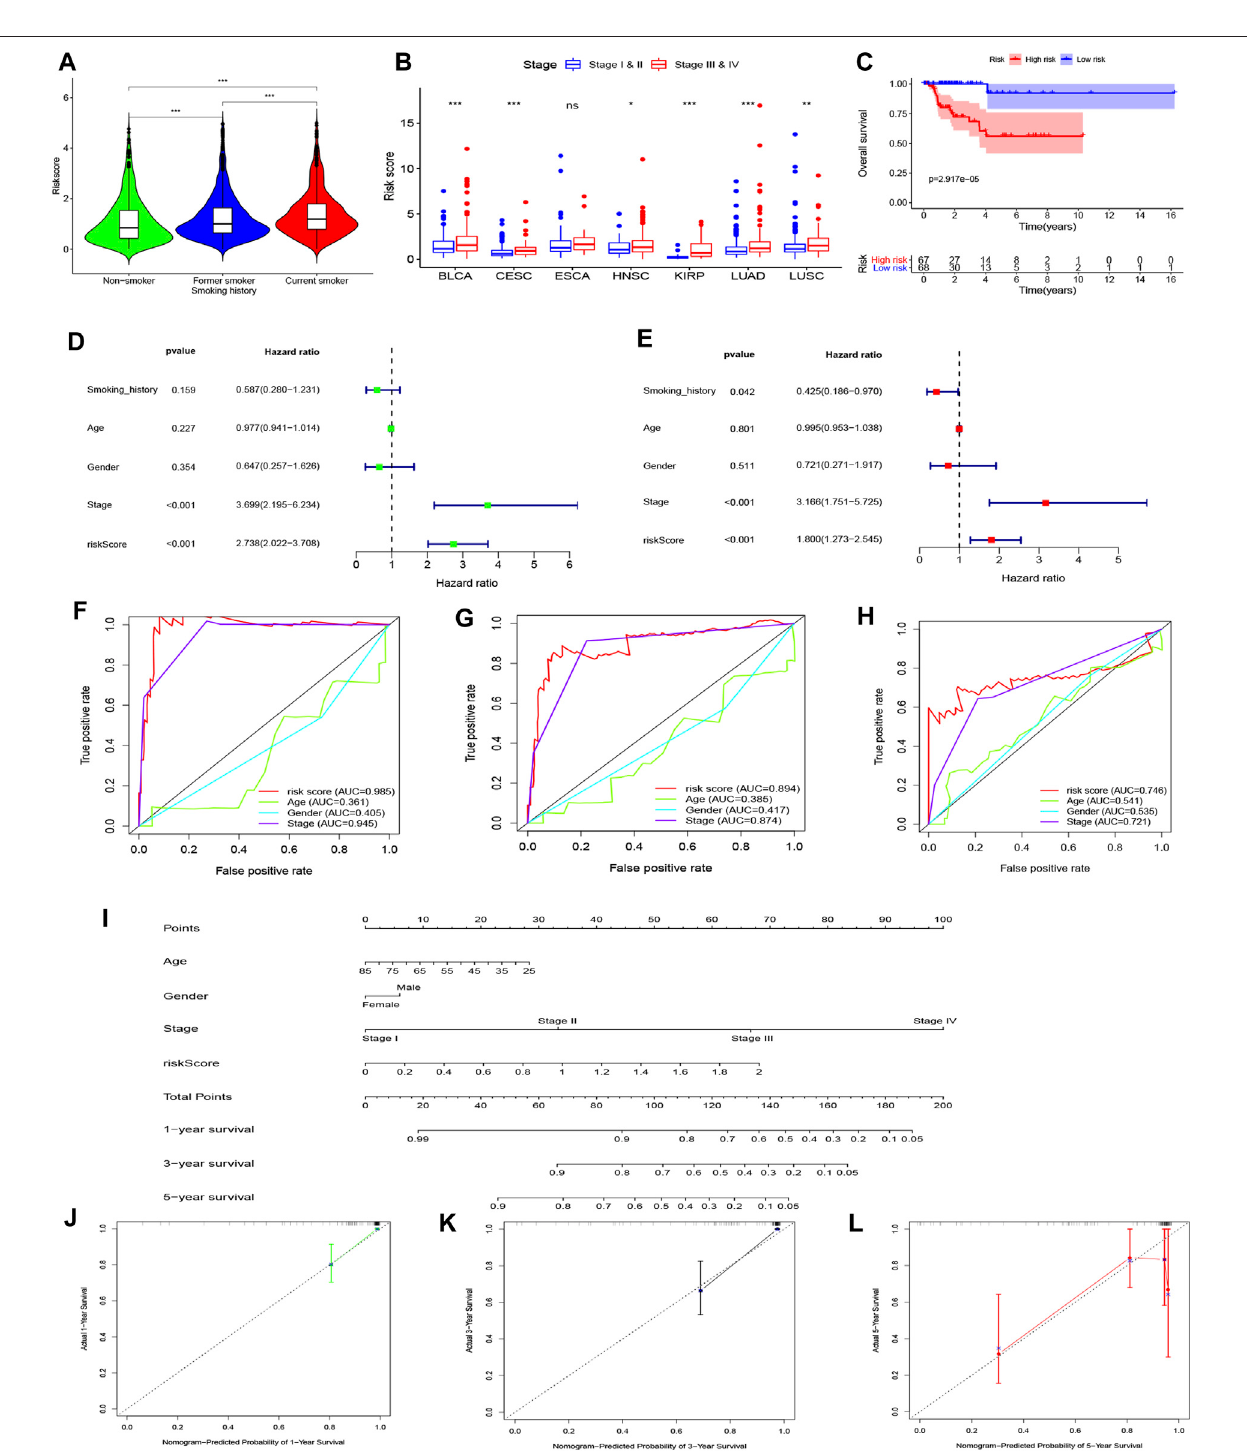
FIGURE 10 | Establishment and validation of a 46-genes prognostic model for KIRP patient ’ s OS. (A) Differences in risk scores among all patients with different smoking histories. (B) Differences in risk scores among patients with different stages. (C) KM curves showed a difference in OS among KIRP patients with different risk scores. (D) Univariate and (E) multivariate Cox regression analyses were applied to analyze the effects of risk scores on OS along with other clinical features. The ROC curves of the ability of the smoking-related model and other clinical features to predict KIRP patient ’ s (F) 1-, (G) 3- and (H) 5-years OS. (I) A nomogram was constructedbycombiningthesmoking-relatedmodelwithage,gender,andstagetopredict1-,3-and5-yearsOSofKIRP.Calibrationdiagramswereappliedtoassess the consistency of nomogram prediction of KIRP ’ s (J) 1-, (K) 3- and (L) 5-years OS with real results.